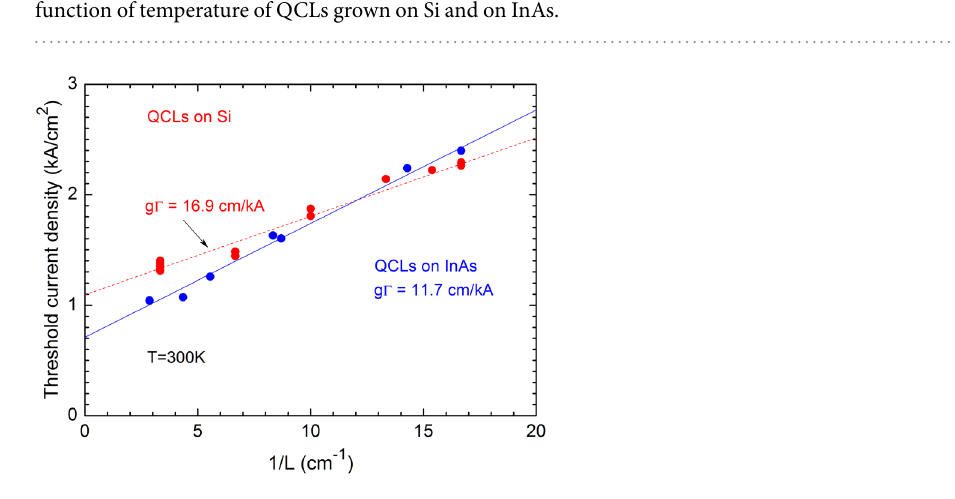
Figure 5. Threshold current density of the studied QCLs as a function of reciprocal resonator length. The plotted values are normalized for the ridge width of 20 µ